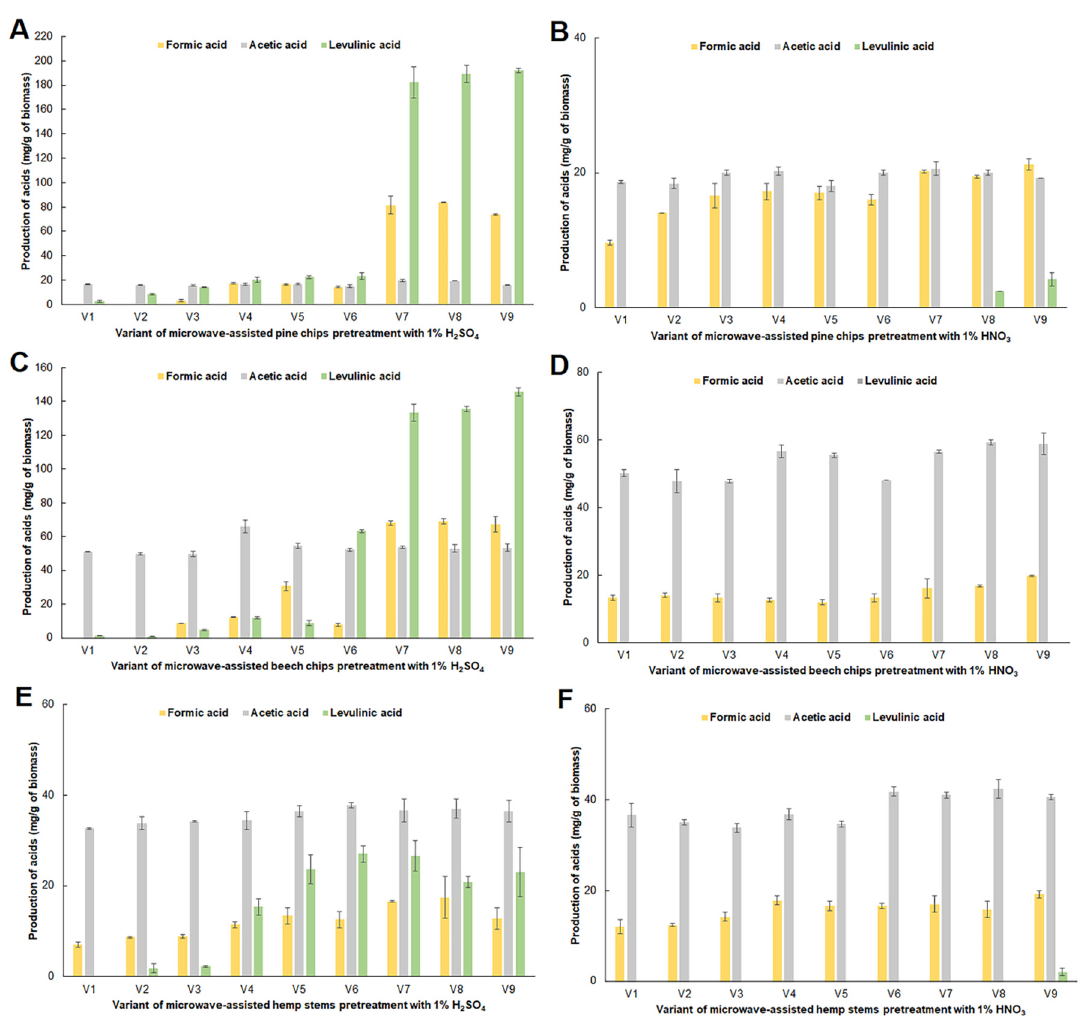
Figure 2. Concentrations of organic acids after microwave pretreatment in experimental variants (( A )—pine chips, 1% v / v H 2 SO 4 ; ( B )—pine chips, 1% v / v HNO 3 ; ( C )—beech chips, 1% v / v H 2 SO 4 ; ( D )—beech chips, 1% v / v HNO 3 ; ( E )—hemp stems, 1% v / v H 2 SO 4 ; ( F )—hemp stems, 1% v / v HNO 3 ).